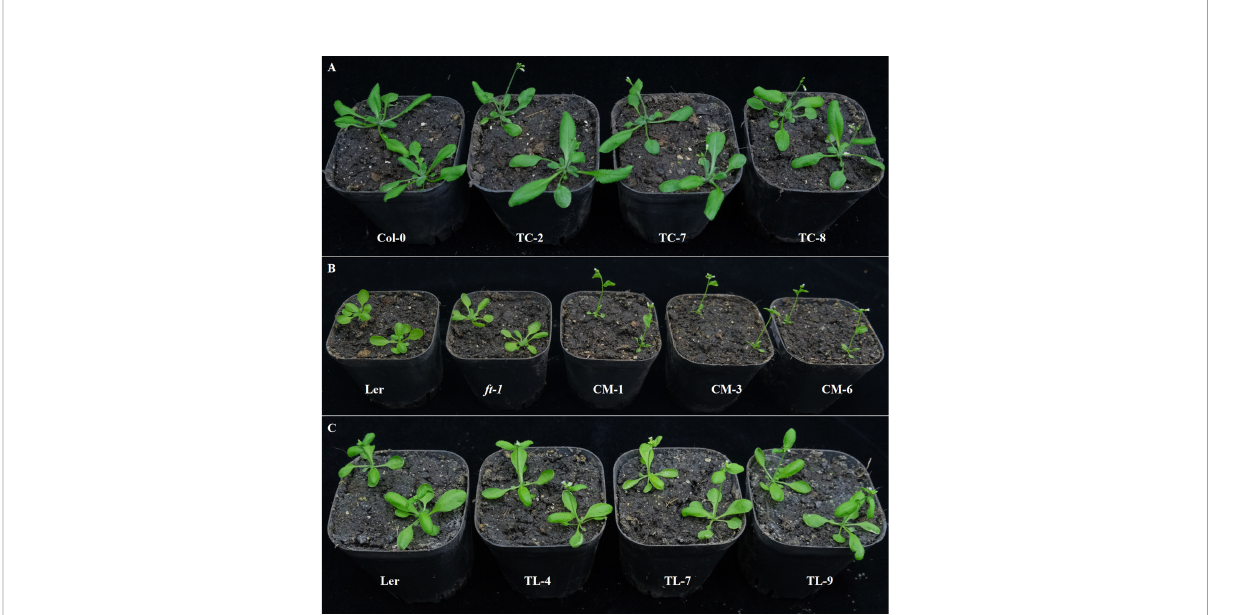
FIGURE 7 Flowering traits of transgenic Arabidopsis lines. (A) From left to right are Col-0, TC-2, TC-7, and TC-8 (29 th DAS). (B) From left to right are Ler, ft-1 , CM-1, CM-3, and CM-6 (20 th DAS). (C) From left to right are Ler, TL-4, TL-7, and TL-9 (22 th DAS).